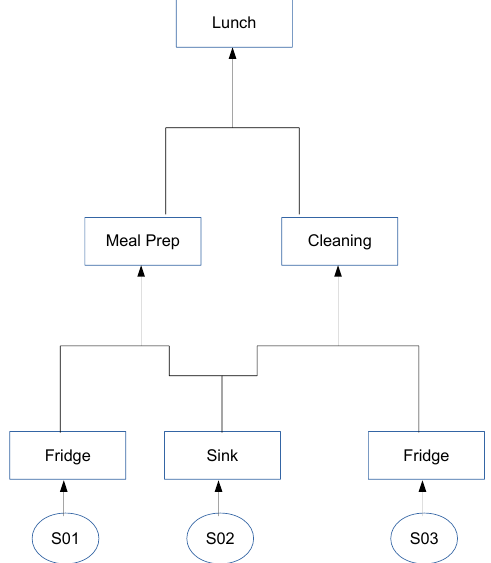
Figure 8. Hierarchical ontology structure adopted in NUG - EVFUS [22] to model activities in a smart